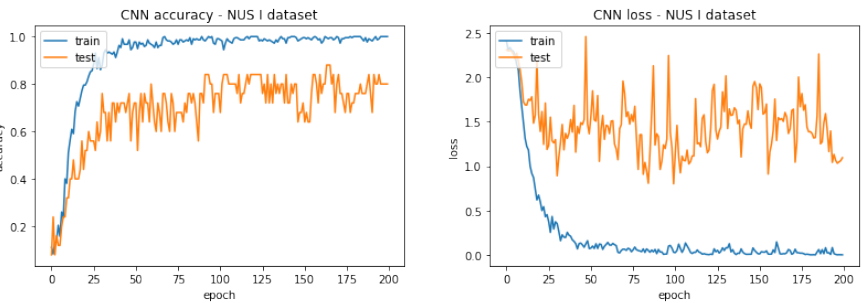
Figure 12. Diagnostic curves for CNN-NUS I